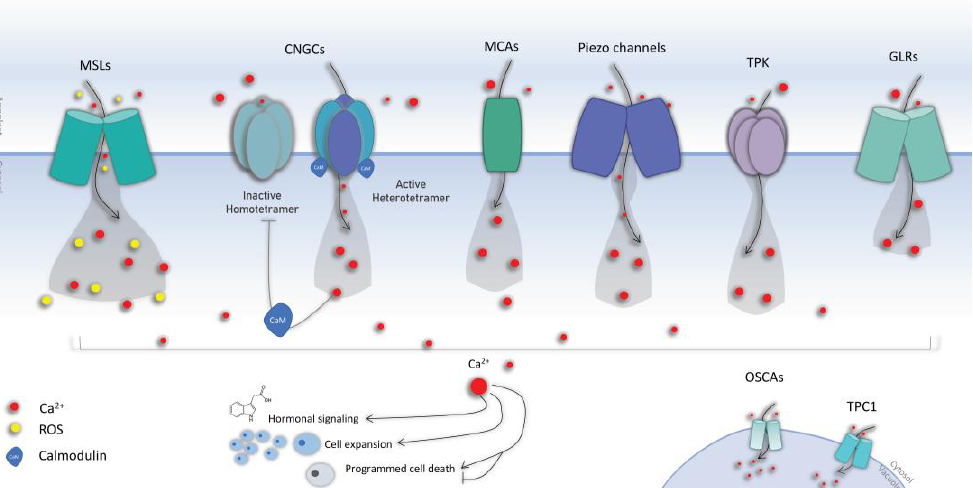
Figure 1. The identified mechanosensitive calcium channels. ( Left to right ) Plasma membrane-embedded mechanosensitive calcium channels include the mechanosensitive channels of small conductance-like (MSLs) and the cyclic nucleotide-gated channels (CNGCs), which may have unique functional characteristics compared with homotetrameric channels in addition to conjugating with calmodulins (CaM). Mid1-complementing activity (MCA) channels, piezo channels, the two-pore domain K + (TPK) channels, and glutamate receptor-like (GLR). Vacuolar mechanosensitive calcium channels include the reduced hyperosmolarity-induced [Ca 2+ ] cyt increase (OSCAs) and two-pore channel (TPC1). The intracellular calcium ions regulate downstream signaling elements including hormonal signaling (ethylene, abscisic acid, and auxin).